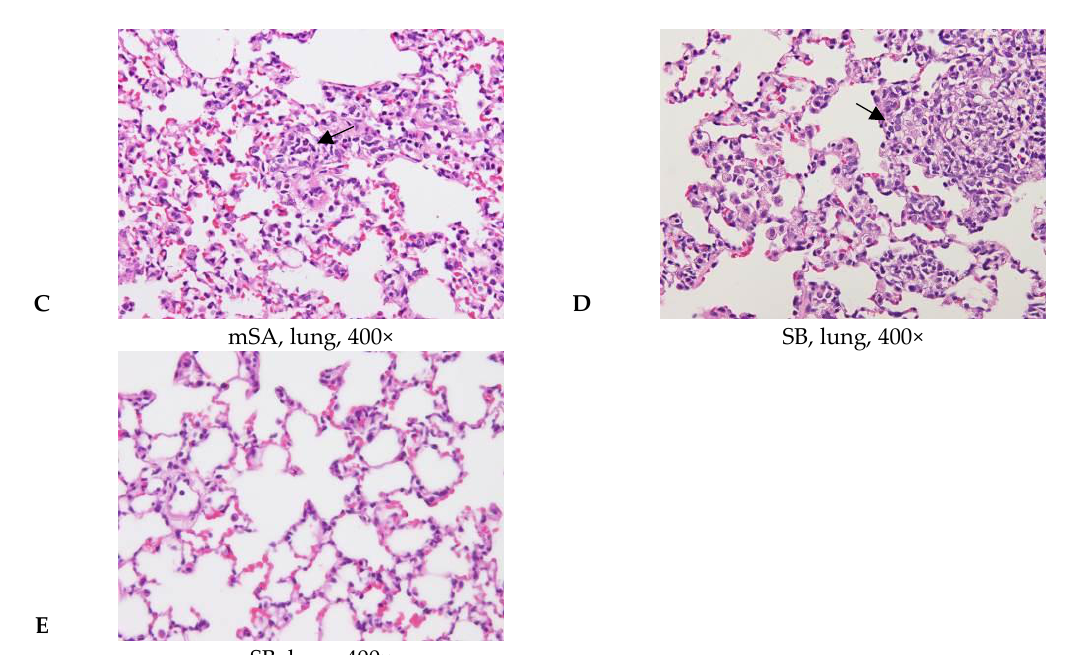
Figure 6. Histopathologic findings of lungs of rats after intratracheal instillation with unmodified and modified nano-silica in the acute pulmonary toxicity study (14 D). Normal architectures of lung in the control group ( A ) and mSB group ( E ), minimal to slight macrophage aggregations of the lung of SA and mSA groups ( B , C ), and slight to moderate macrophage aggregations with minimal to slight granulomatous inflammation of the lung of SB group ( D ) were found in rats. Negative control: R.D.W, 0.5 mL/kg bw, i.t.; SA: sample A, 0.645 mg/kg bw, 320× diluted, 0.5 mL/kg bw, i.t.; mSA: modified sample, 0.06 mg/kg bw, 320× diluted, 0.5 mL/kg bw, i.t.; SB: sample B, 2.24 mg/kg bw, 80× diluted, 0.5 mL/kg bw, i.t.; mSB: Table 12. Summary of pathological incidence and pathological scores of rats after intratracheal instilled with unmodified and modified nano silica on Day 14.